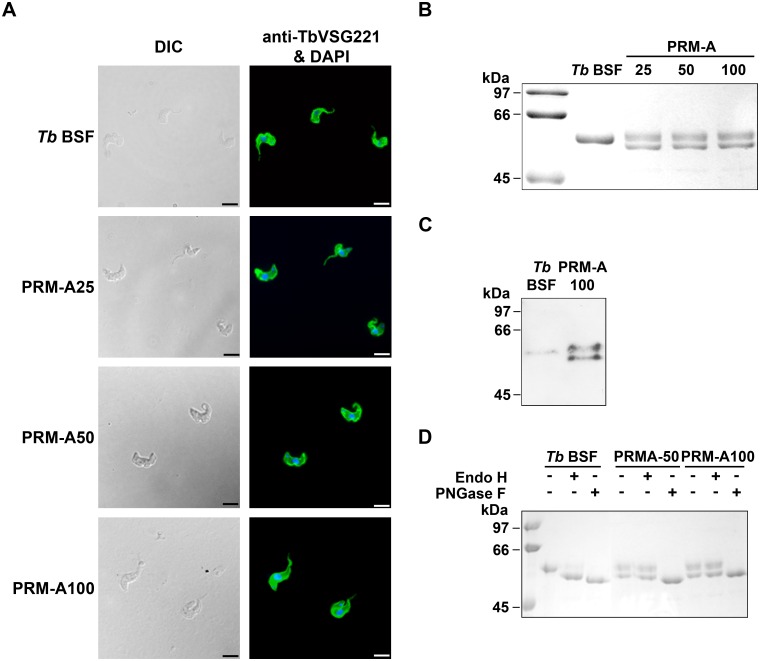
Analysis of the nature and N-glycosylation status of the VSG expressed in PRM-A-resistant trypanosomes.(A) Indirect immunofluorescence microscopy analysis of VSG221 expression in parasites resistant to PRM-A probed with a polyclonal antibody against VSG221. Nuclear and kinetoplast DNA was stained with DAPI. Bars, 10 μm. (B) sVSGs of parental and resistant strains were purified as described [20] and analysed by SDS/PAGE and Coomassie blue staining. (C) Western-blot analysis of sVSG isolated from parental and PRM-A100 cells using an anti-TbVSG221 polyclonal antibody. (D) Endoglycosidase treatment of sVSG samples with Endo H (that removes oligomannose N-linked glycans) or PNGase F (that removes all N-linked glycans), followed by SDS/PAGE and Coomassie blue staining analysis.